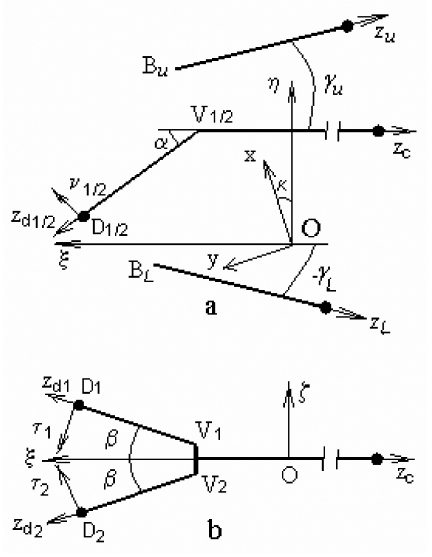
Fig. 4. Schematic model of a multi-rod stabilizer: (a) in the arrow plane and (b).in the transverse